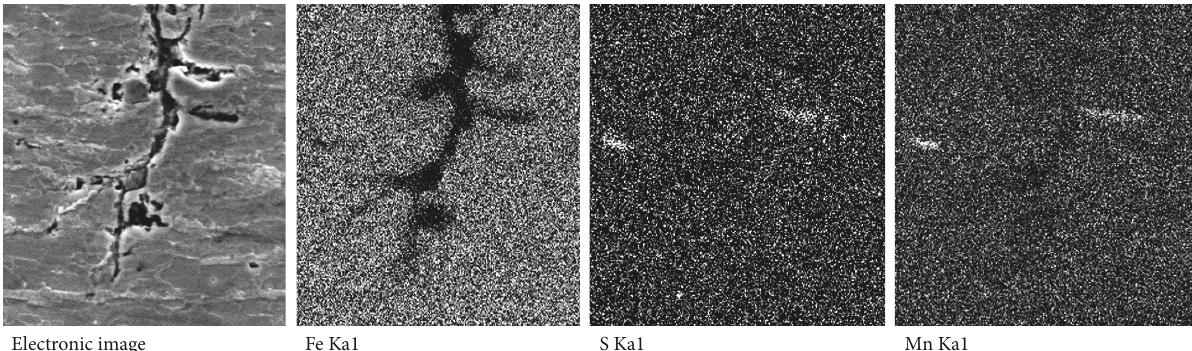
Figure 12: Maps of elements distribution in a stress corrosion crack. Increased local sulfur content (manganese